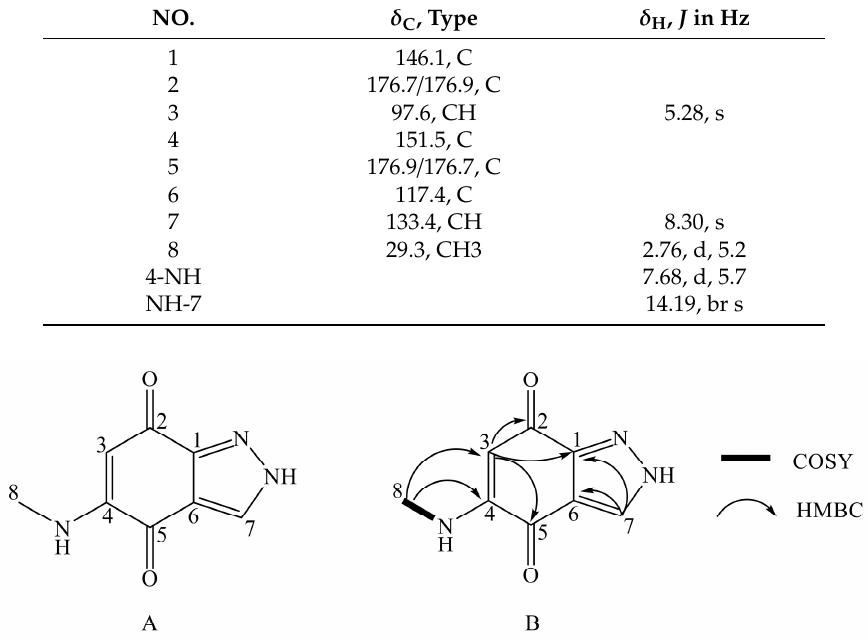
Figure 2. ( A ). Chemical structure of 1 . ( B ). Key 2D NMR correlations of 1. Table 1. 1 H (500 MHz) and 13 C (125 MHz) NMR data of ( 1 ) in dimethyl sulfoxide (DMSO)- d 6.